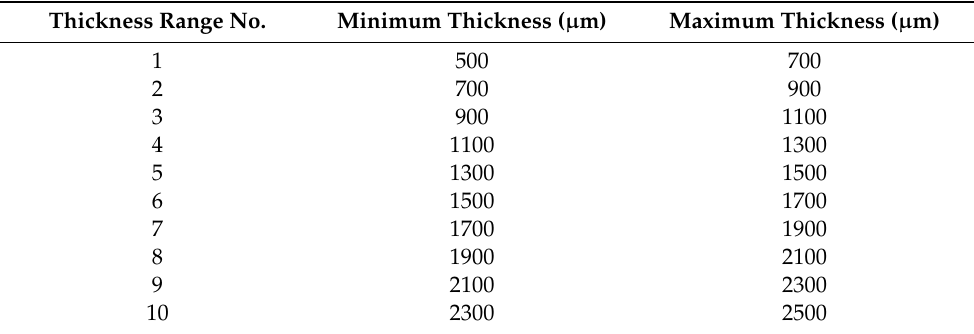
Table 2. List of considered thickness